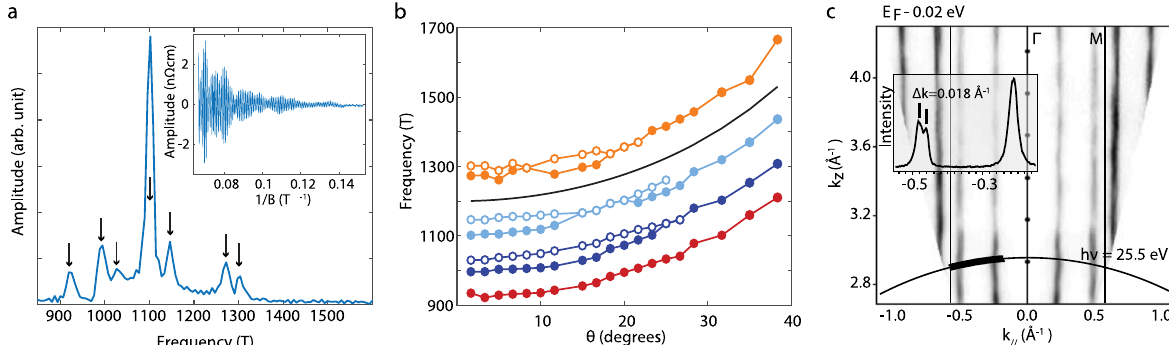
Fig. 2 Quantum oscillations and k z dispersion. a Shubnikov – de Haas oscillations at 0.1 K for a magnetic fi eld parallel to the c -axis. The main panel shows the frequency components obtained by Fourier transform of the quantum oscillation trace shown in the inset. The peaks correspond to Fermi surface pockets. The background subtraction used was a third-order polynomial and the fi eld sweep rate was 0.05 T/min. The noise level is 50 pVHz − 1/2 . b Angle dependence of the QO frequencies for angle θ from the c -axis. The solid black line is a 1/cos θ dependence expected for a quasi-two-dimensional Fermi surface. c ARPES k z dependence in the M Г high-symmetry direction at E = − 20 meV, showing only slight modulations of the band along the c